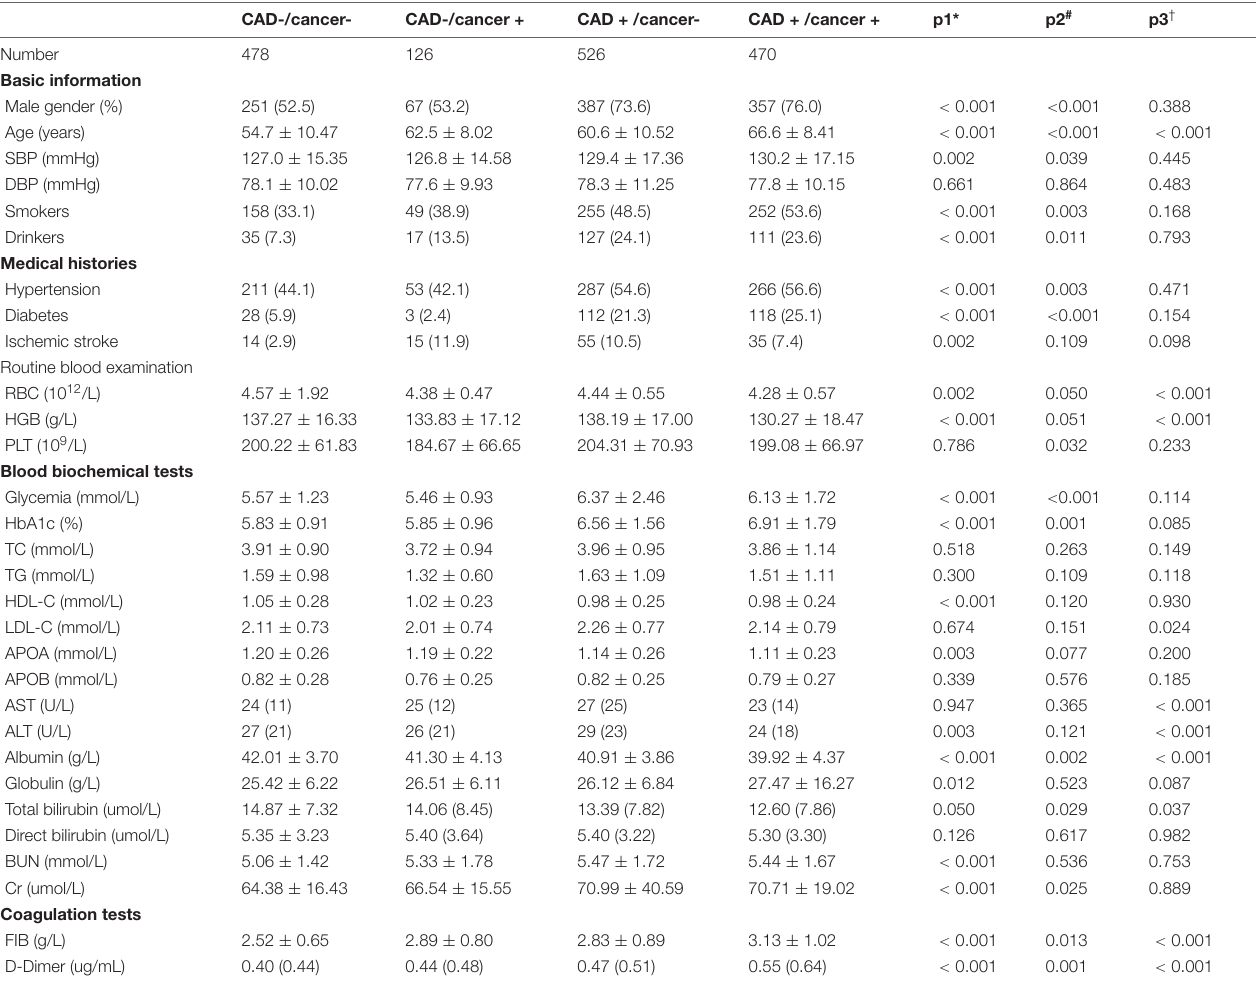
*p1 represents comparison between the CAD-/cancer- and CAD + /cancer + groups. # p2 represents comparison between the CAD-/cancer + and CAD + /cancer + groups. † p3 represents comparison between the CAD + /cancer- and CAD + /cancer + groups. ALT, alanine aminotransferase; AFP, alpha fetoprotein; APOA/APOB, apolipoprotein A/B; AST, aspartate aminotransferase; BUN, blood urea nitrogen; CAD, coronary atherosclerotic disease; Cr, creatine; DBP/SBP, diastolic/systolic blood pressure; FIB, fibrinogen; HbA1c, glycosylated hemoglobin; HDL/LDL-C, high/low-density lipoprotein-cholesterol; HGB, hemoglobin; PLT, platelet; TC, total cholesterol and TG, triglyceride. Measurement values that conform to normal distribution are described as mean ± SD, others as median (interquartile range). Enumeration data was expressed as n (%).